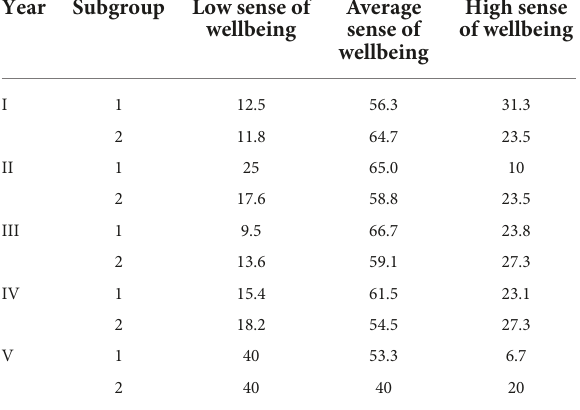
TABLE 7 Frequency of occurrence of different wellbeing levels in psychology students after classes (in %). Year Subgroup Low sense of Average wellbeing sense